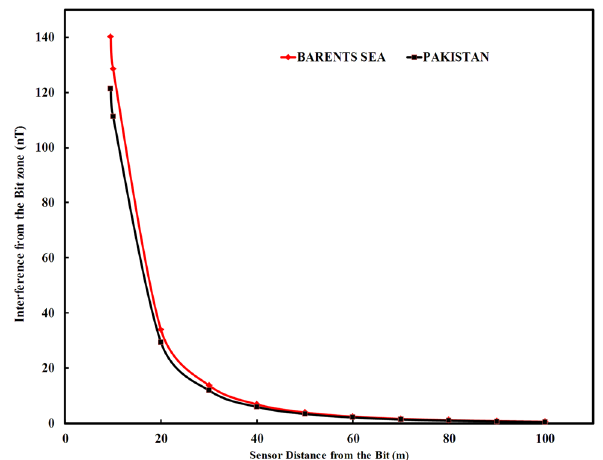
Fig. 4 Bit interferences from different NMDC